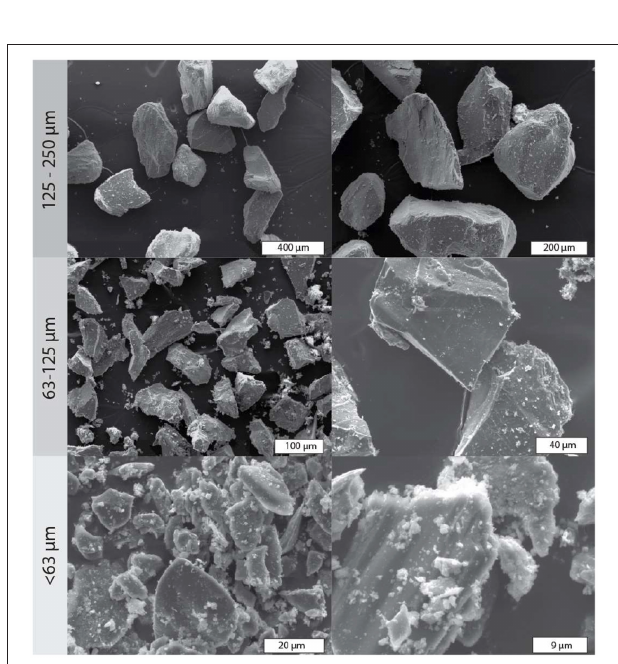
FIGURE 4 | Scanning electron microscope images of daughter olivine particles of varying size fractions recovered from our experimental run products (Experiment A2). Smaller size fractions show less pitted surfaces and more angularity compared to the parent particles. Very fine surface derived chips produced by abrasion are observed adhering to larger particles within each size